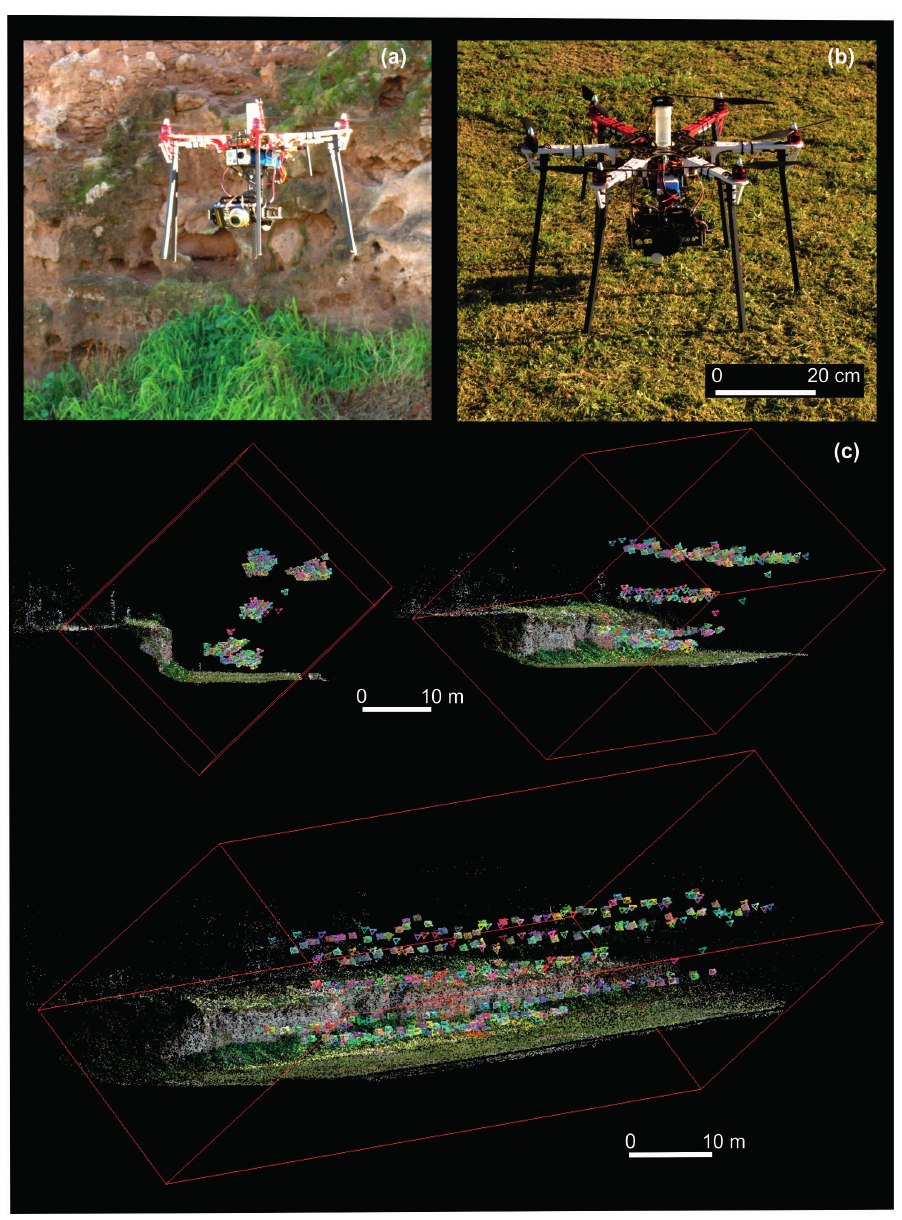
Figure 2. ( a , b ) UAV hexacopter; ( c ) Three different views of all the camera (and photos) positions showing the UAV track along the vertical surface; also, the scattered point cloud (323,847 points) built from the matching can be